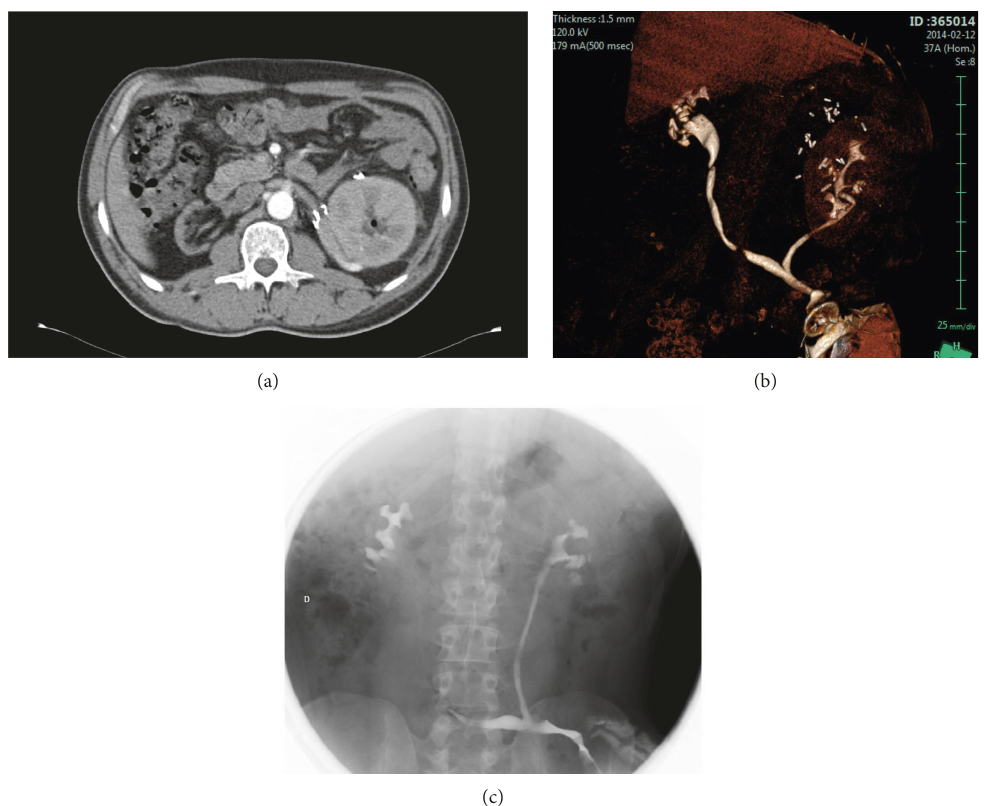
Figure 8: (a). CTscan showing an orthotopic kidney transplantation with the venous reconstruction of the left renal vein. (b) (adapted from Hevia et al.) and (c) are a reconstructed CT image of the urinary system and intravenous urography, respectively, representing a ure- teroureterostomy in orthotopic renal transplantation in a patient with a history of myelomeningocele and cystectomy with cutaneous